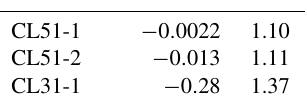
lines concern the constant κ assumption with κ = 0 . 96 (short dashed) and κ = 1 . 24 (long dashed) as the range of uncer-